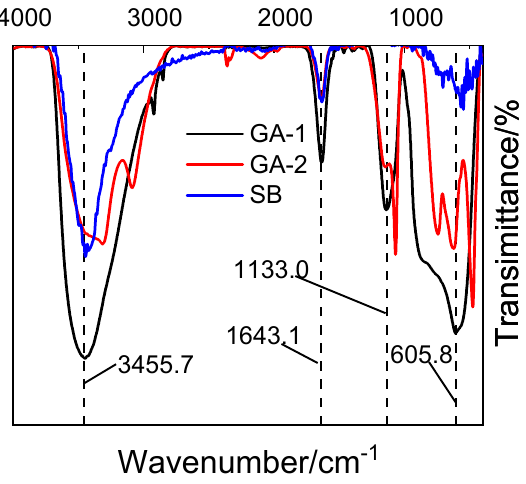
Figure 4. Fourier transform infrared (FT-IR) patterns of different alumina adsorbents.